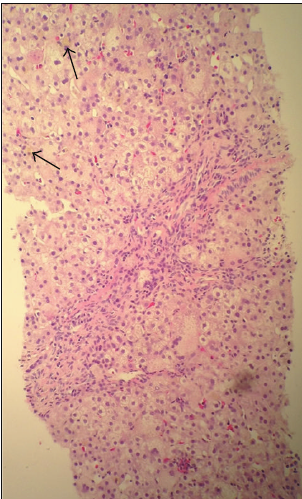
Figure 2: Liver biopsy at 200x magnification showing ballooning hepatocytes (arrows) with inflammation around the portal vein ( ∗